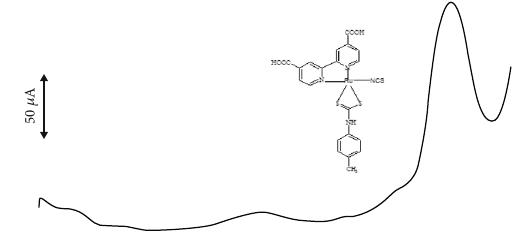
Figure 9: Square wave voltammogram of FC